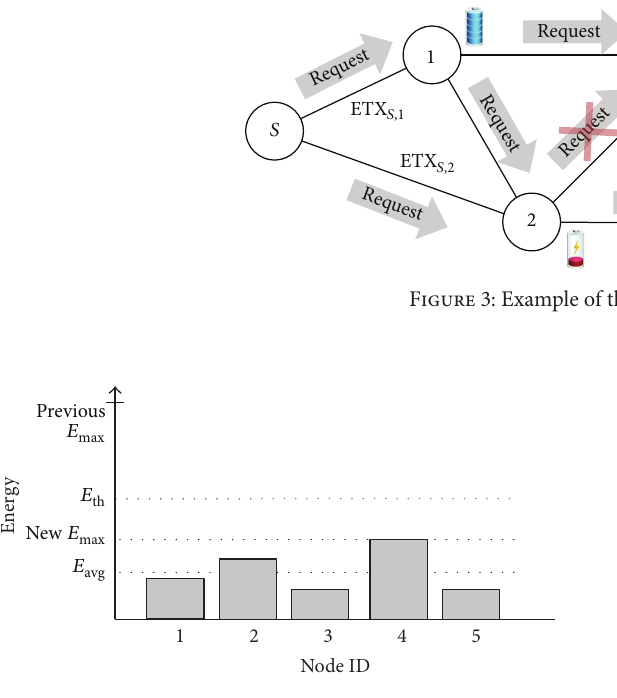
Figure 4: Example of the advanced EEPR algorithm.